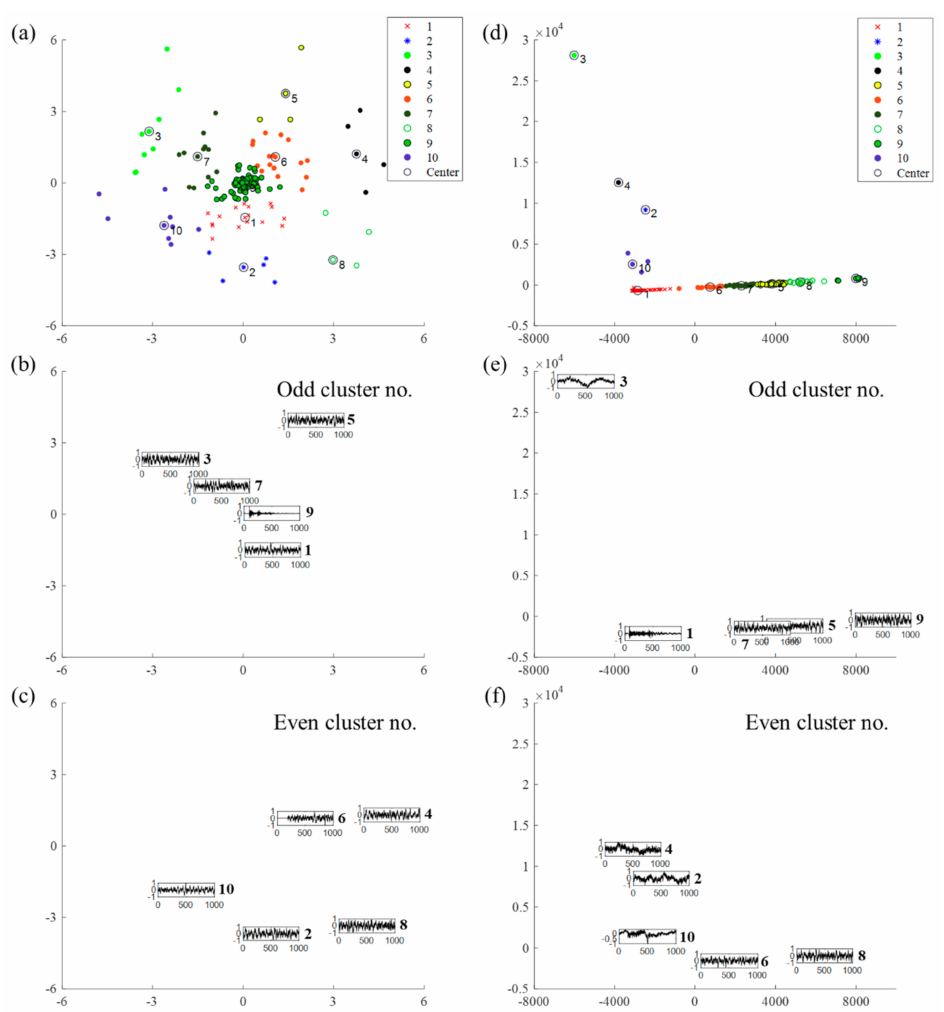
Figure 14. Clustered results of ( a – c ) the normalized and ( d – f ) fast Fourier transformed (FFT) data by k-medoids and cluster representative